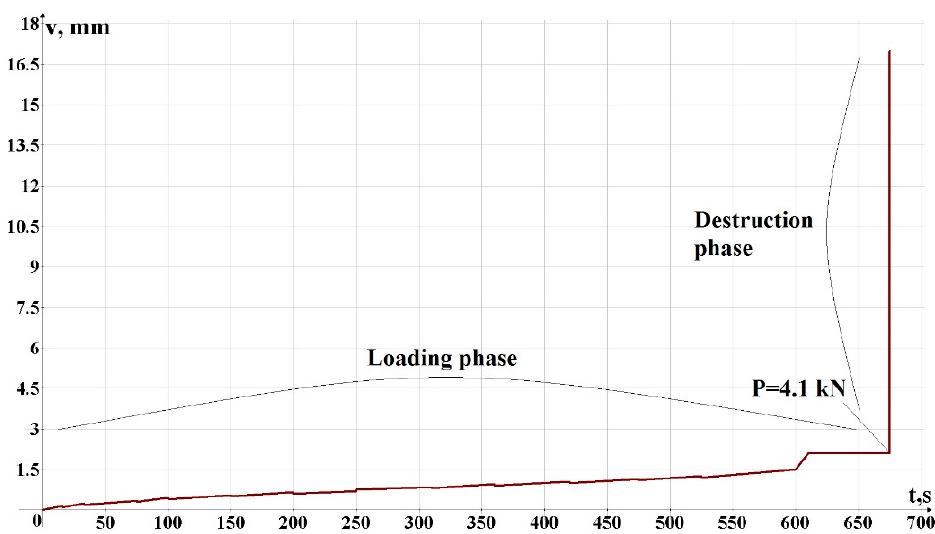
Figure 22. Change in the deflections of the truss, mm ( y -axis) in time, s ( x -axis). Experiment No. 3. A sharp jump in displacements at the end of the graph corresponds to the moment of destruction of the upper chord of the truss. The destruction of the upper chord of the truss occurred after the formation of three plastic hinges in the places of preliminary weakening of the chord